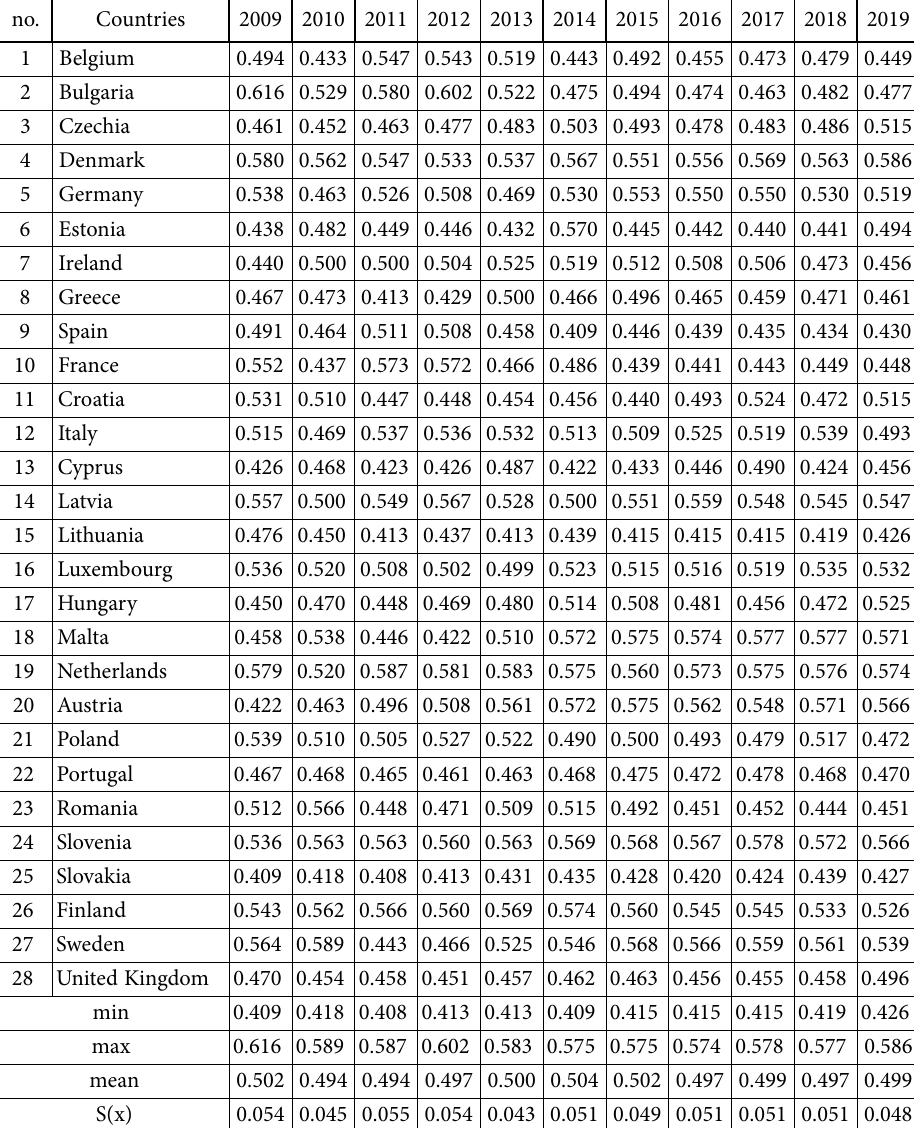
Table 2. The level of sustainable development of EU countries in 2009–2019